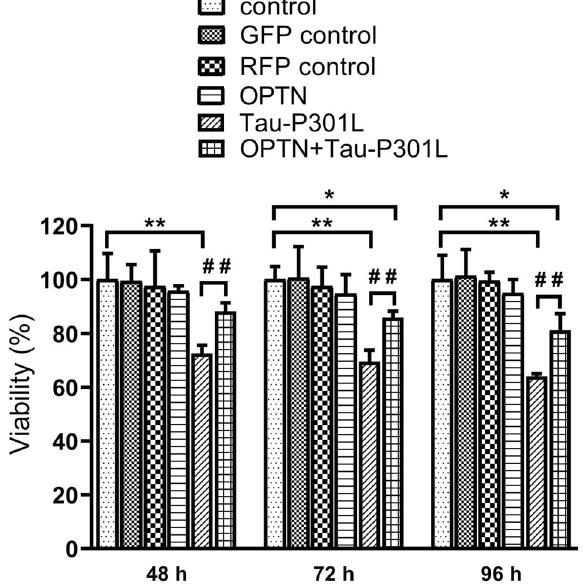
Fig. 1 AAV- OPTN enhanced the viability of infected with AAV- MAPT -P301L in vitro. Data are presented as mean ± SD, the experiment was performed with sextuplicate in two independent sets, * P < 0.05, ** P < 0.01 compared with control; ## P < 0.01 com- pared with TAU-P301L. GFP green fl uorescent protein, RFP red fl uorescent